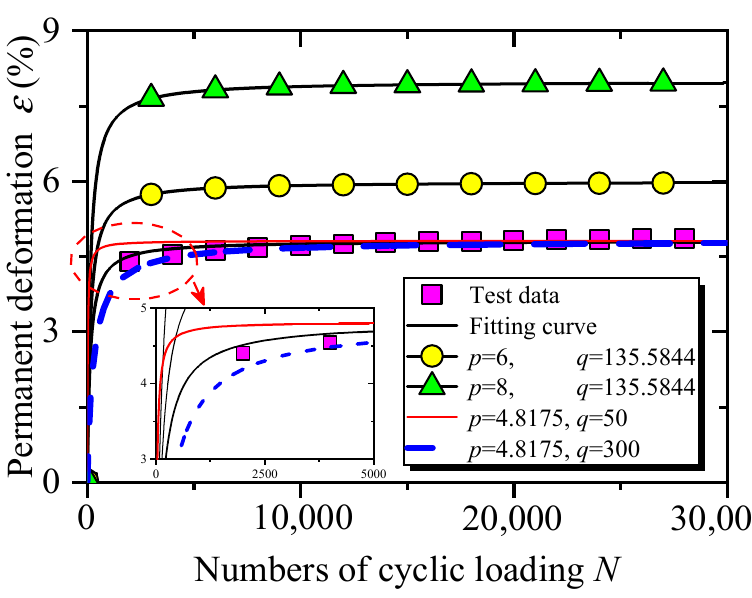
Figure 13. Model parameters analysis.